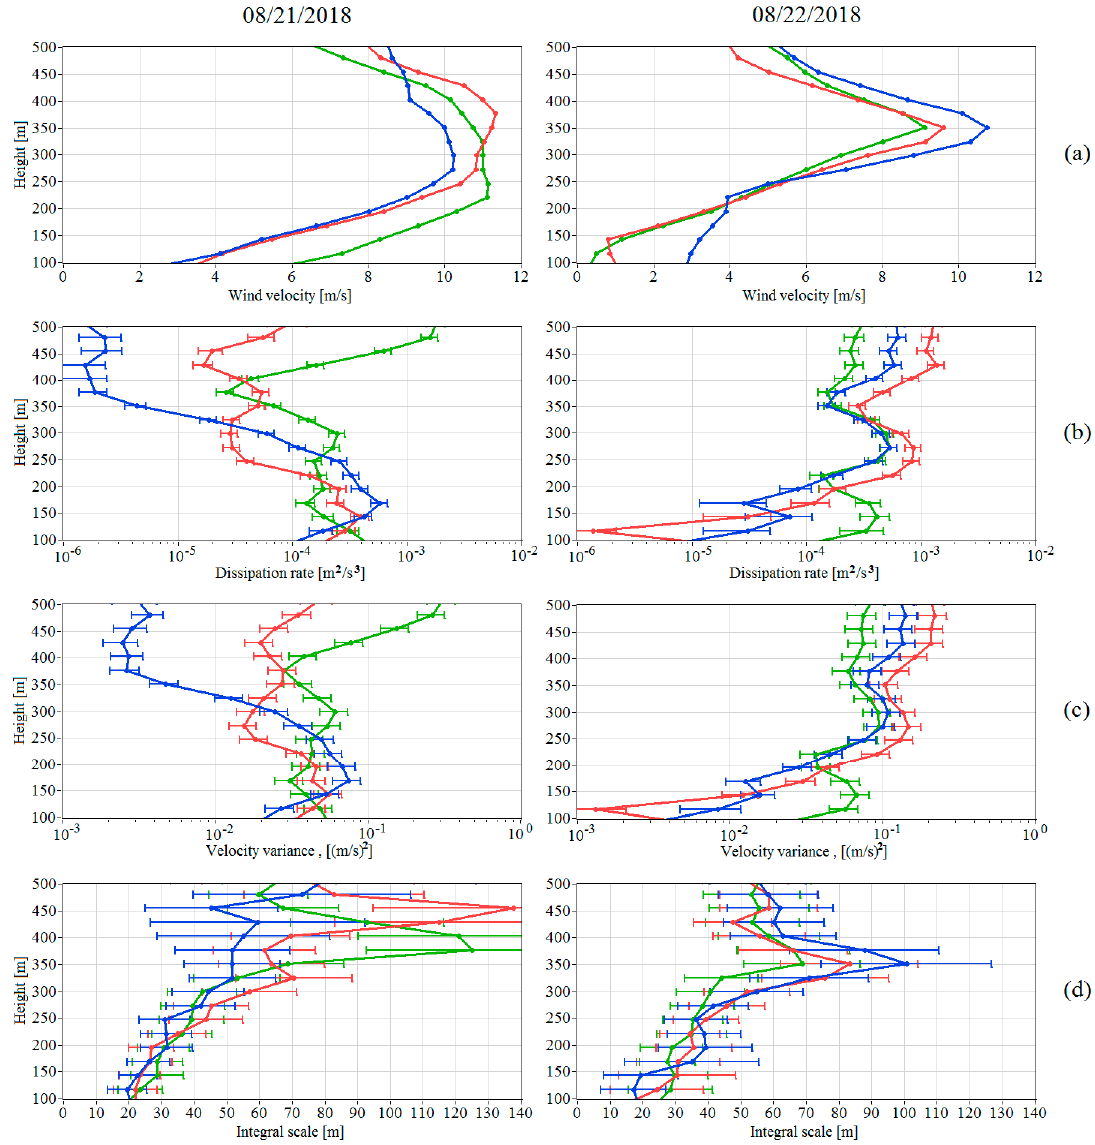
Figure 9. Vertical profiles of wind velocity ( a ), turbulent energy dissipation rate ( b ), variance of the radial velocity ( c ), and integral scale of turbulence ( d ) at 02:00 (blue curves), 04:00 (red curves), and 06:00 LT (local time; green curves) during LLJs on 21 (left) and 22 (right) August 2018. The data are taken from Figure 7.